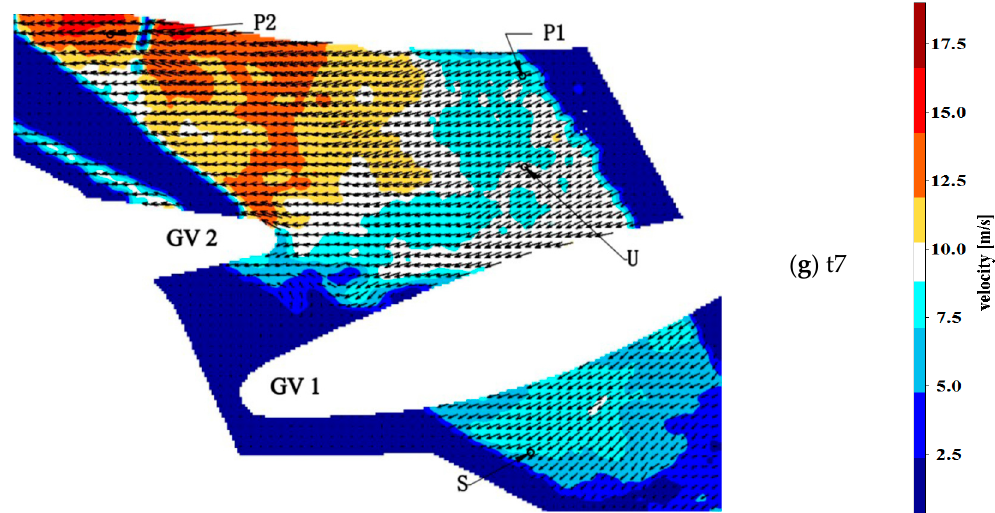
Figure 6. Distribution of flow velocity at different time steps during the stall process presented in Figure 5: ( a ) later recovery, ( b ) highest of velocity at point S, ( c ) highest of discharge Q*, ( d ) minimum of Vr at point S, ( e ) 0.01s after t4, ( f ) stalled stage, ( g ) early recovery. In each figure, the flow field from the PIV measurement result is the part between the two green lines shown in ( a ).